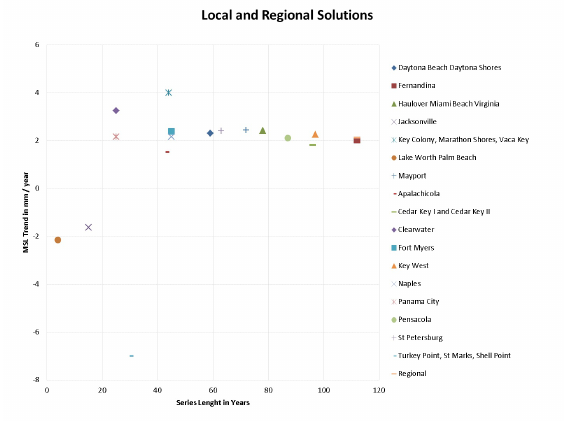
Figure 2. Mean sea level trend estimates for individual local time se- ries and regional solution. Observe the reduced variability with increased series length.